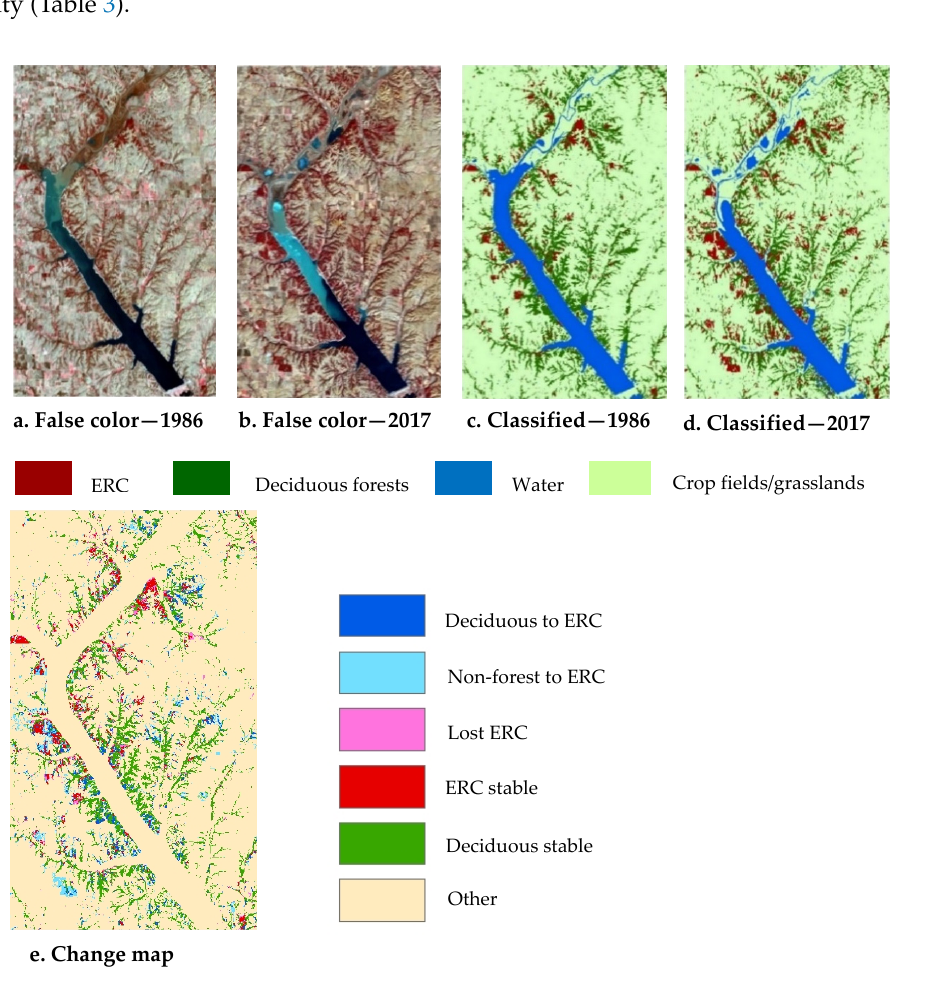
Table 3. Area estimation with 95% confidence intervals—Tuttle Creek Reservoir.